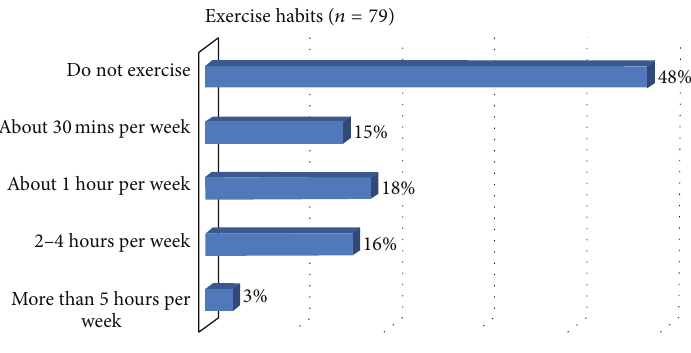
Figure 2: Preintervention exercise habits. Table 1: Preintervention and postintervention measured screening health indicators ( 𝑛 = 79 ).